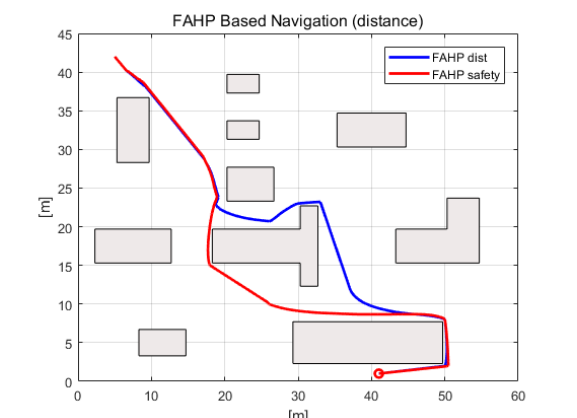
Figure 12. Comparison between short distance and high safety RM based FAHP path planning.